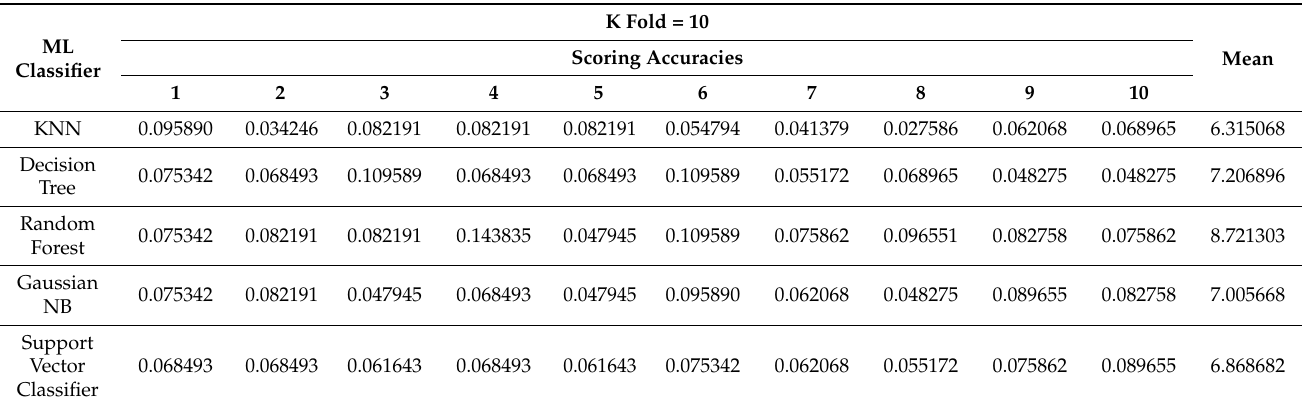
Table 6. Analysis result of different machine learning classifiers to classify dengue disease by using 10-K-fold cross-validation and mean as a result of 10 iterations.